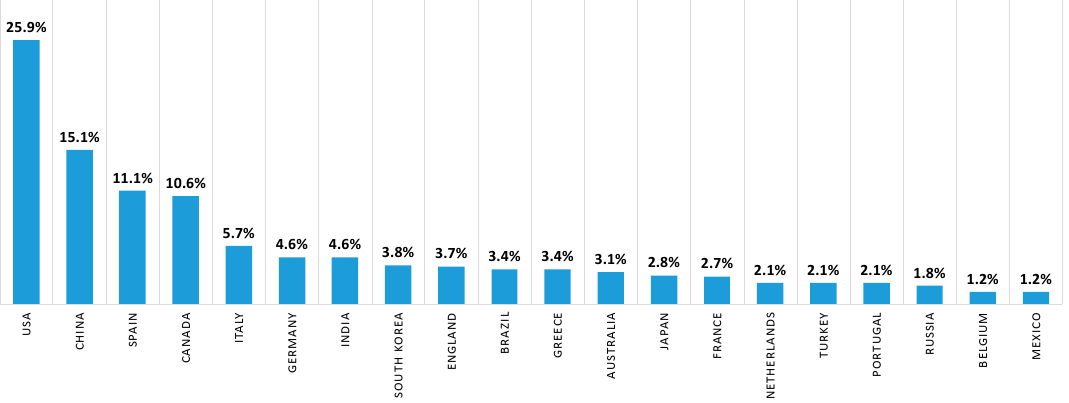
Figure 9. Organizations and agencies that funded most of the published articles for forest fire detection in the imaging research area. Data retrieved from Web of Science [134] for dates between 1990 to October 2020.